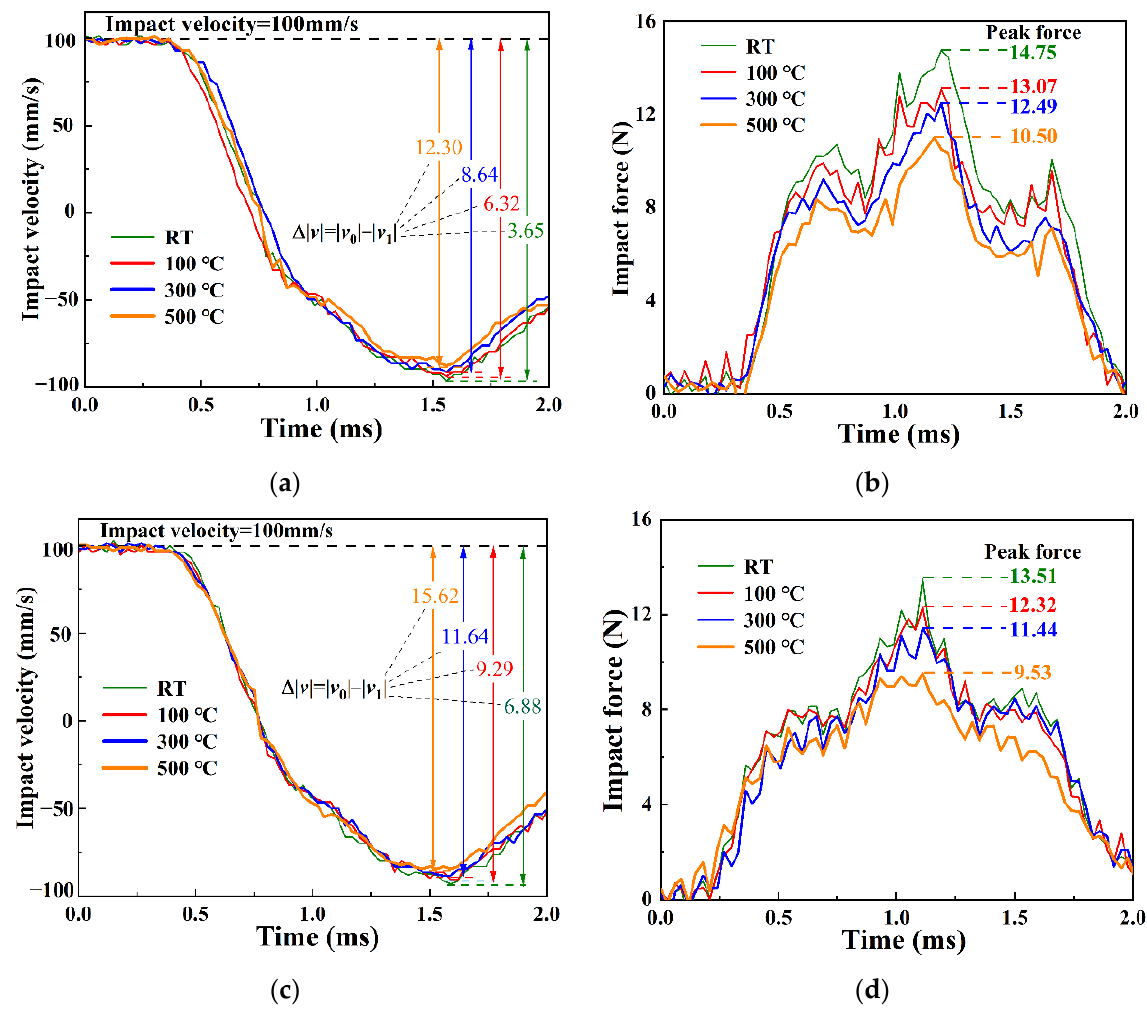
Figure 4. The impact velocity and force–time diagrams for different experimental conditions (impact cycle is 10 4 ): ( a ) No sand, velocity − time, ( b ) No sand, contact force − time, ( c ) sand, velocity − time, ( d ) sand, contact force −